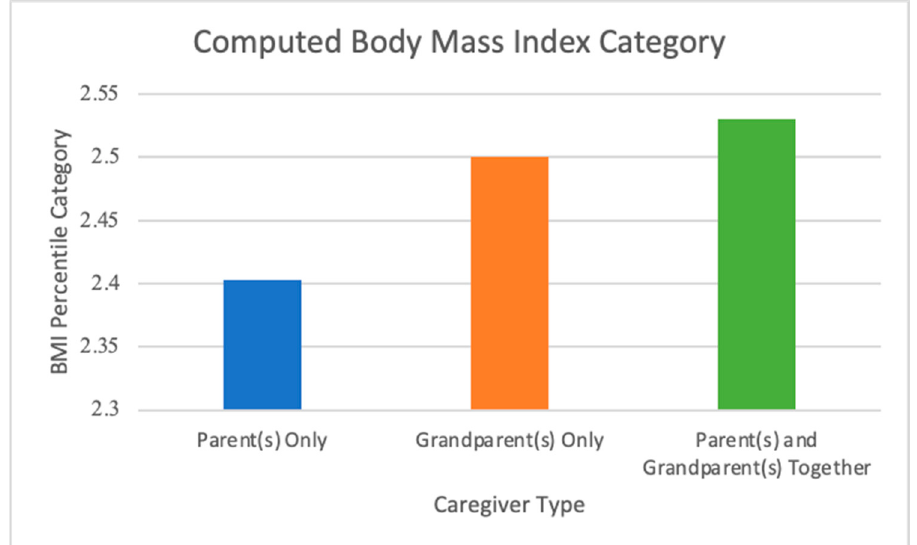
Figure 3. Adolescents’ average computed Body Mass Index percentile grouped by type of primary caregiver, controlling for socioeconomic status. Categories range from 1 = underweight (less than 5th percentile) to 4 = overweight (greater than 95th percentile) based on 2000 CDC categorizations.